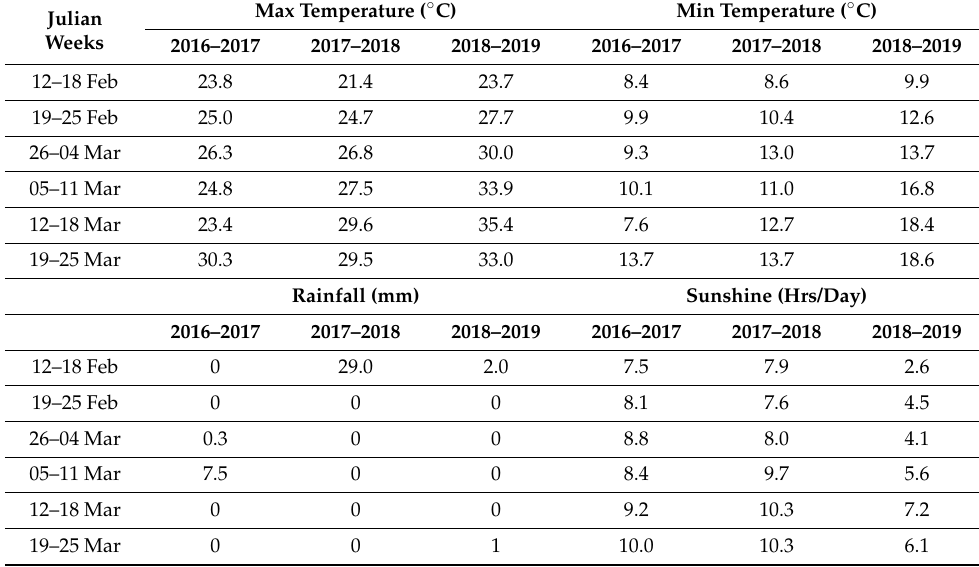
Table 6. Meteorological information for the grain filling period of three growing